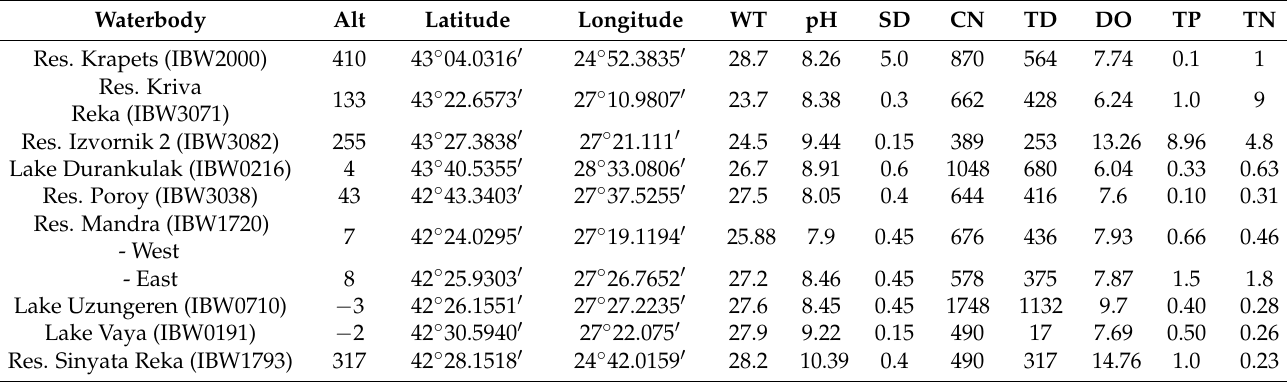
Table 1. Sampling sites and their main environmental parameters in August 2019. Legend: IBWXXXX–number of the waterbody in the Inventory of Bulgarian wetlands [18]; SD–sampling date; Alt–altitude (m a.s.l.); WT—water temperature ( ◦ C), SD—Secchi depth (m); CN—conductivity ( µ S); TD—total dissolved solids ( µ g L − 1 ); DO—oxygen concentration (mg L − 1 ); TP—total phosphorus (mg L − 1